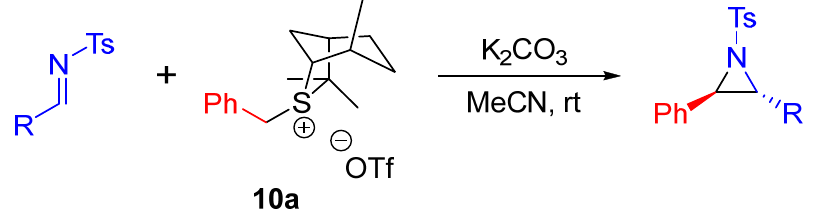
Scheme 24. Aggarwal’s enantioselective aziridination.